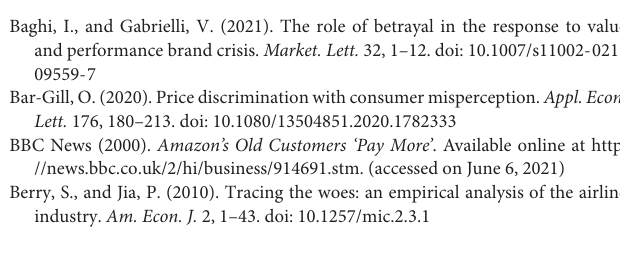
algorithmic price discrimination, consumers who